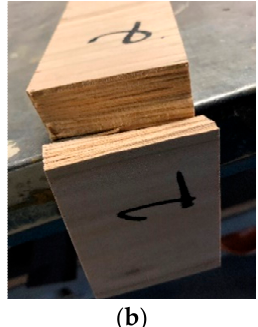
Figure 7. Typical wood shear failure observed during the shear tests performed. ( a ) Surface-bonding specimens (Bi) and ( b ) edge-bonding specimens (Ei).